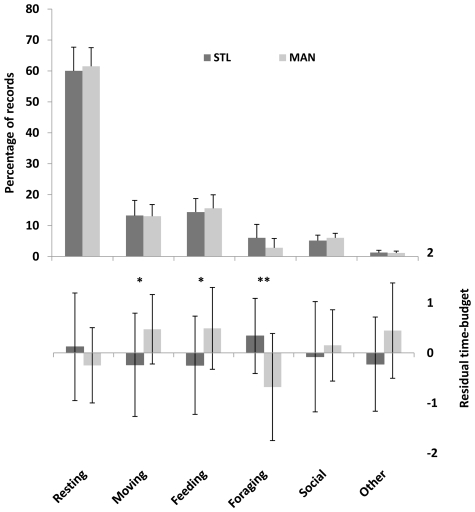
Time-budget of collared lemurs at the two study sites.Upper quadrant: monthly percentages of instantaneous records. Lower quadrant: residuals of log-transformed time budget controlling for log-transformed group size. Values are means and standard errors. STL: Sainte Luce; MAN: Mandena; * p<.05; ** p<.001.